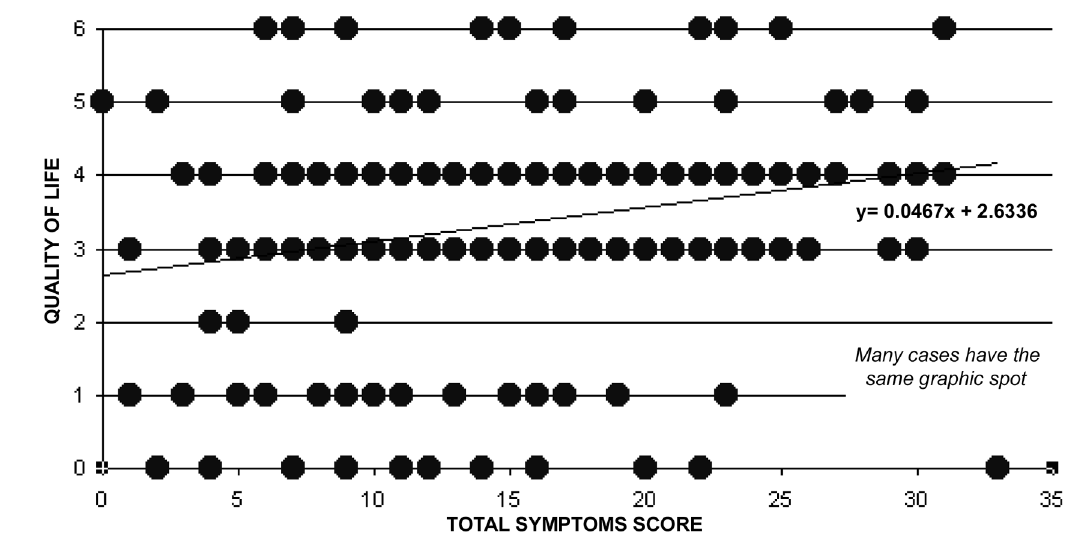
Figure 1 – Correlation between total symptoms score and quality of life in 400